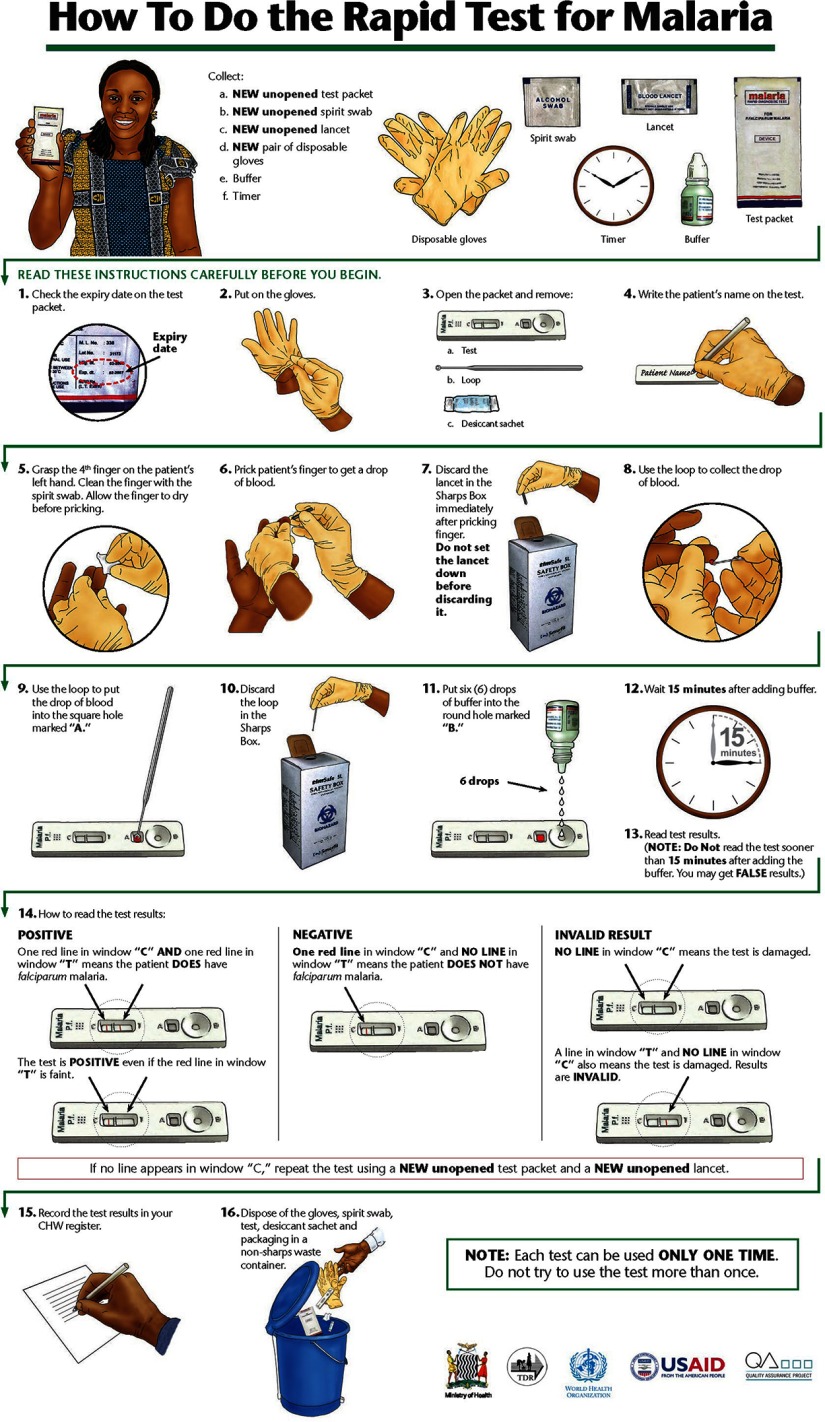
Malaria Rapid Diagnostic Test Job AidA job aid for community health workers lists at the top all supplies and equipment that the worker needs to assemble prior to conducting a rapid diagnostic test for malaria.